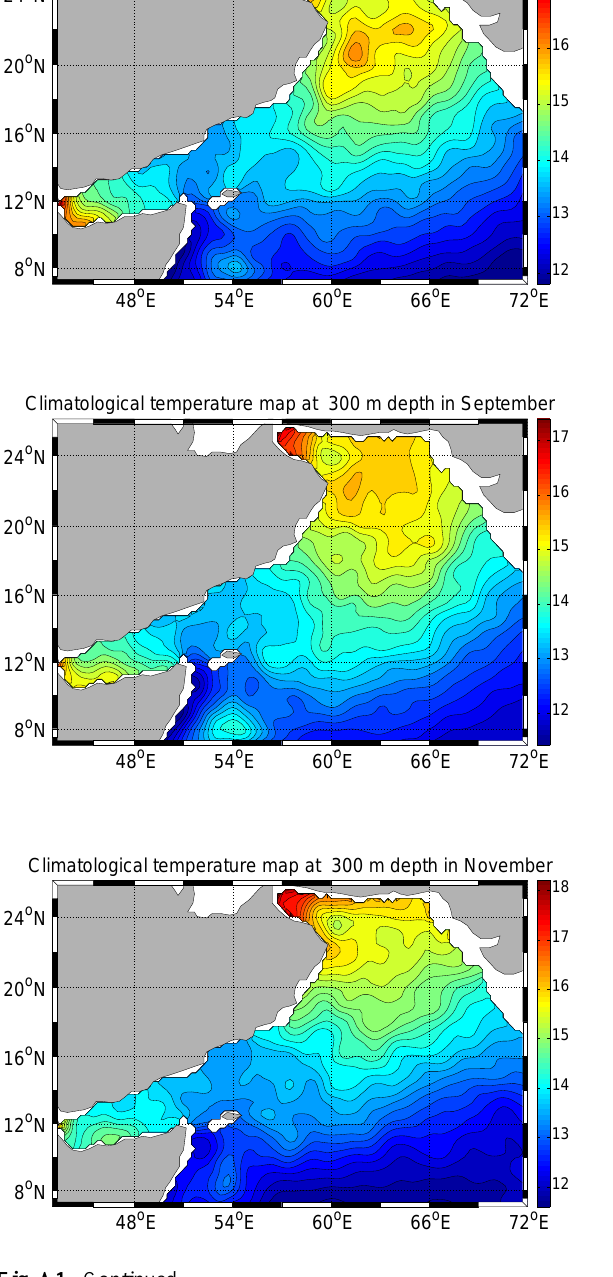
Fig. A1. Figure 26: (Continued from previous page) Horizontal maps of temperature (in o C , left) and salinity (right) at 300 m depth for January, March, May, July, September, November (from top to bottom), from the climatology